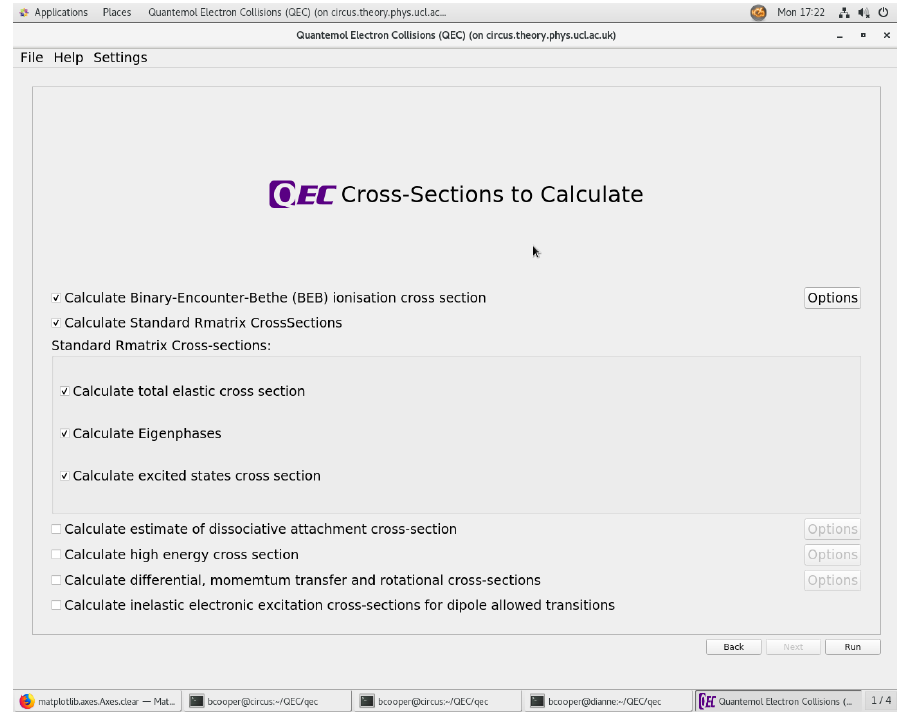
Figure 4. Sample screen for a close-coupling (CC) calculation on methane showing the outputs selected to be total cross section, the eigenphase sums for each symmetry, the rate of elastic scattering as a function of temperature and the ionization cross section computed using the binary encounter Bethe (BEB)